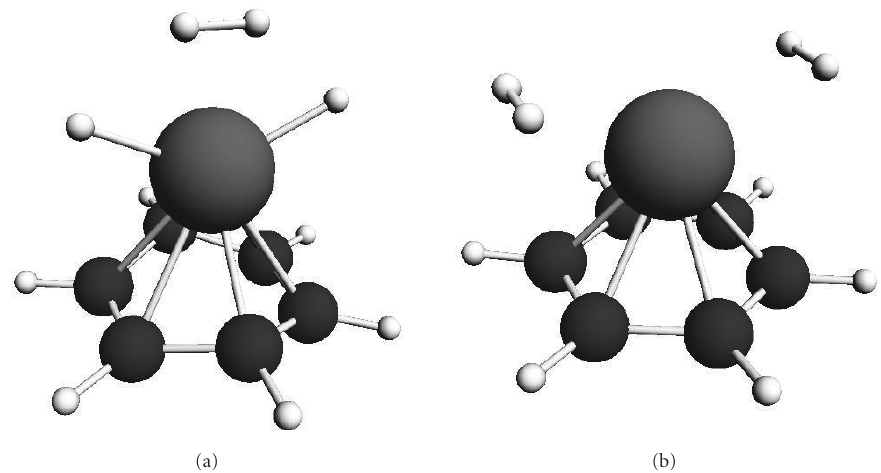
Figure 6: Adsorption patterns of two H 2 molecules addition: (a) C 6 H 6 Ti H 2 -H 2 , (b) C 6 H 6 Ti -2H 2 . Hydrogen, carbon, and titanium atoms are shown in white, dark grey, and light grey, respectively.